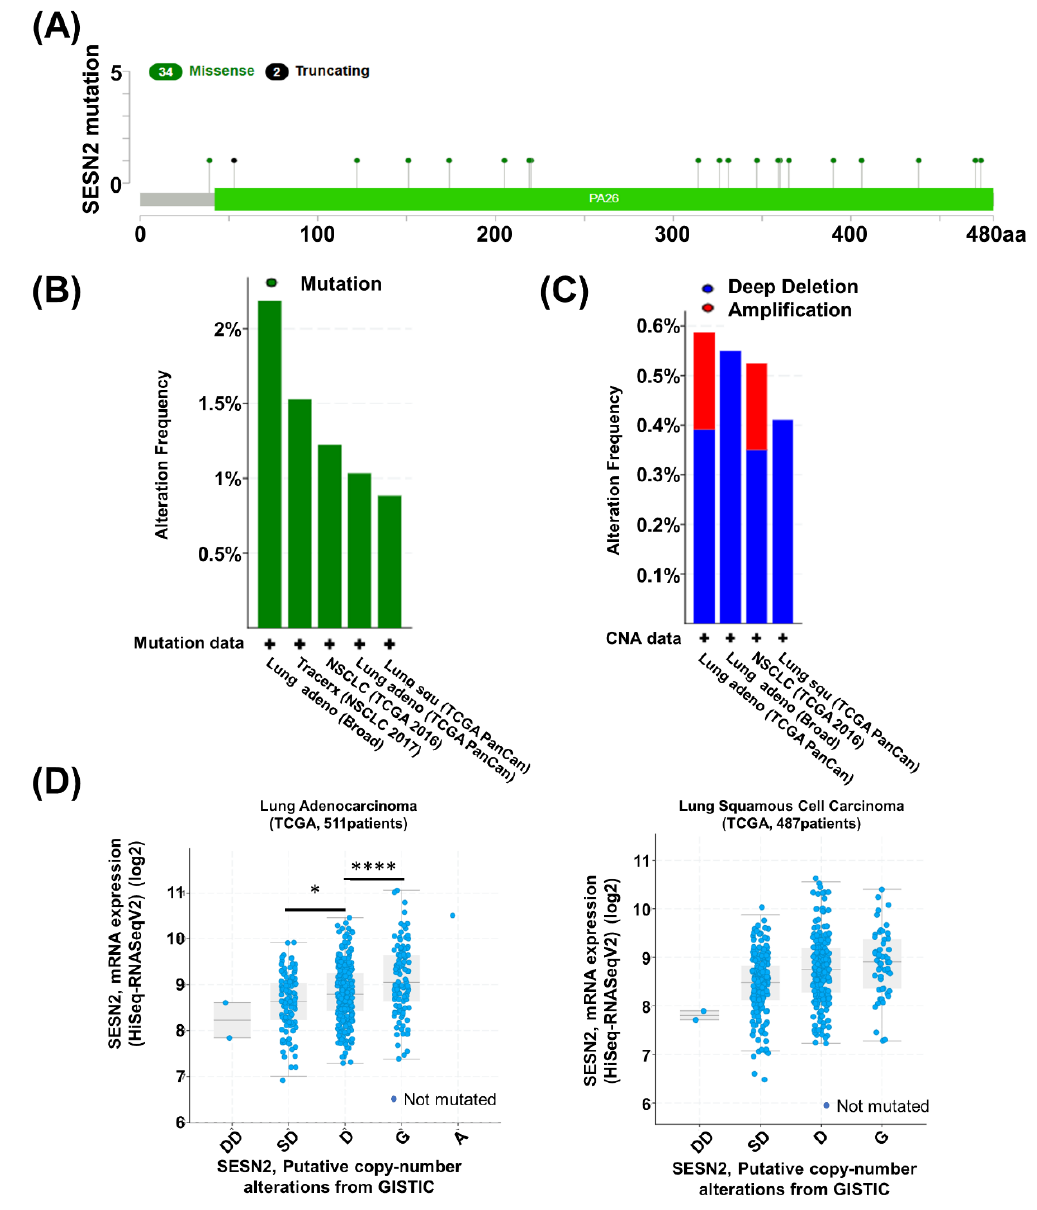
Figure 5. Sestrin2 mutation and alteration in TCGA lung cancer. ( A ) The mutation plot shows the location and type of mutation in Sestrin2. ( B ) Sestrin2 mutation analysis using cBioportal. Green: mutation. ( C ) Sestrin2 alteration analysis using cBioportal. Red: amplification; blue: deep deletion. ( D ) Copy number alteration of Sestrin2 mRNA expression in TCGA lung adenocarcinoma and TCGA lung squamous cell cancer datasets. Sestrin2 expression positively related to the copy number alteration status, deep deletion (DD), shadow deletion (SD), diploid (D), gain (G), and amplification (A). (* p < 0.05; **** p < 0.0001).